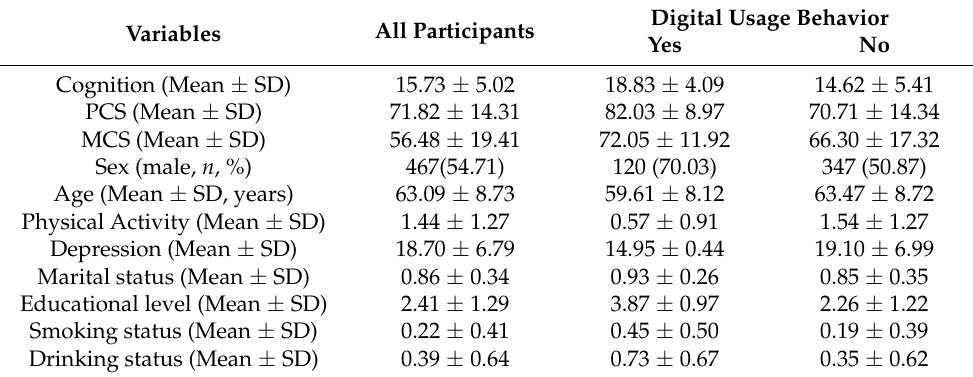
Table 3. Descriptive Statistics ( n = 854).